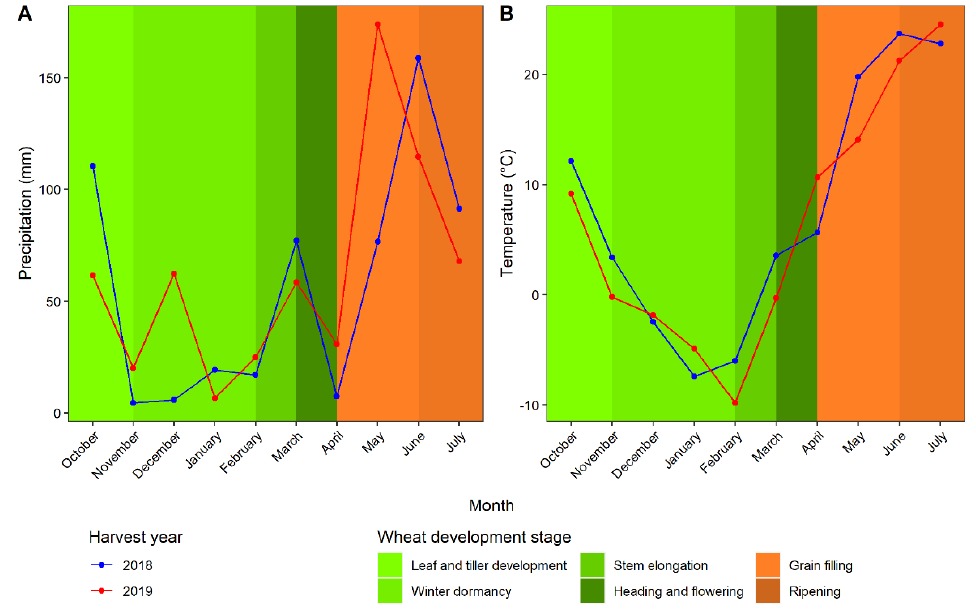
Figure 1. Precipitation ( A ) and temperature ( B ) condition and wheat development at Mead, NE, USA in 2018 and 2019.